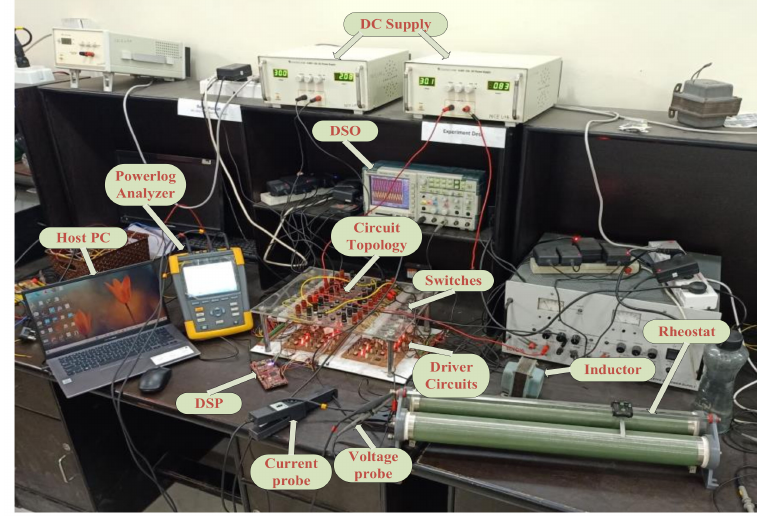
Figure 10. Hardware setup of the proposed topology.